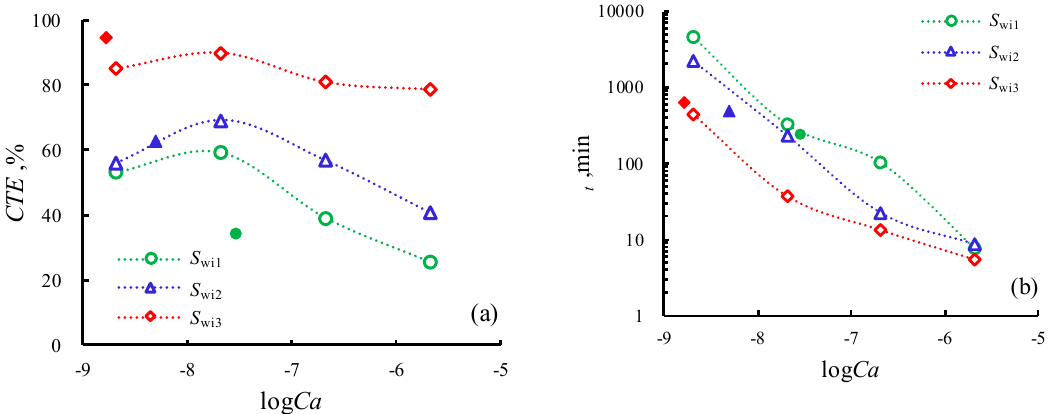
Figure 8. The capillary trapping efficiency and time for experiments to reach a stable state in the imbibition experiments (solid points represent the spontaneous imbibition experiments and hollow points represent the forced imbibition experiments, while the details of experiment samples refer to Figures 3 and 4): ( a ) capillary trapping efficiency; ( b ) the time for experiments to reach stable state.